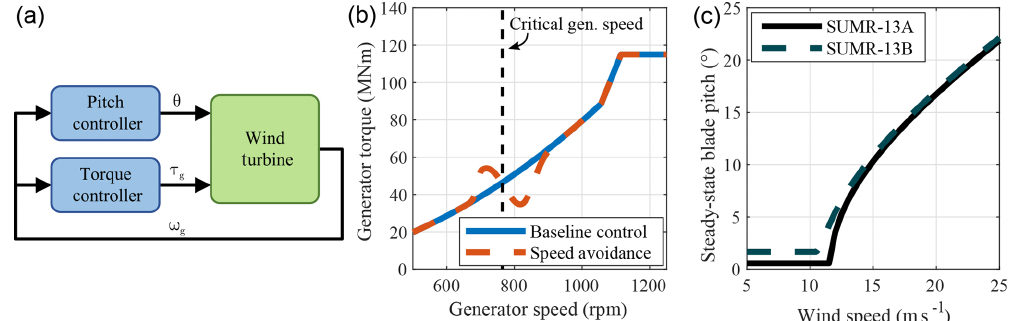
Figure 2. Baseline control block diagram, where θ is the pitch angle, τ g is the generator torque, and ω g is the measured generator speed (a) . The torque control signal (b) for baseline control (blue) and speed avoidance control (red) to avoid the critical generator speed. Steady-state blade pitch angles (c) for the SUMR-13A and